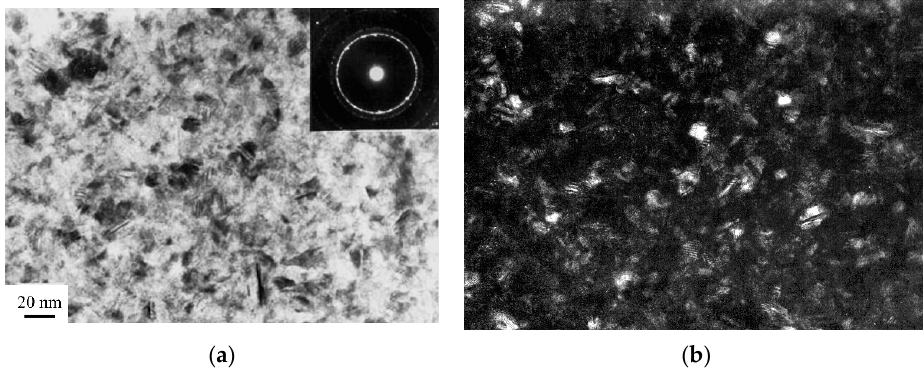
Figure 1. ( a ) Bright-field and ( b ) dark-field electron microscope images of the microstructure of (Ni70Mo30)90B10 sample after annealing at 873 K for 144